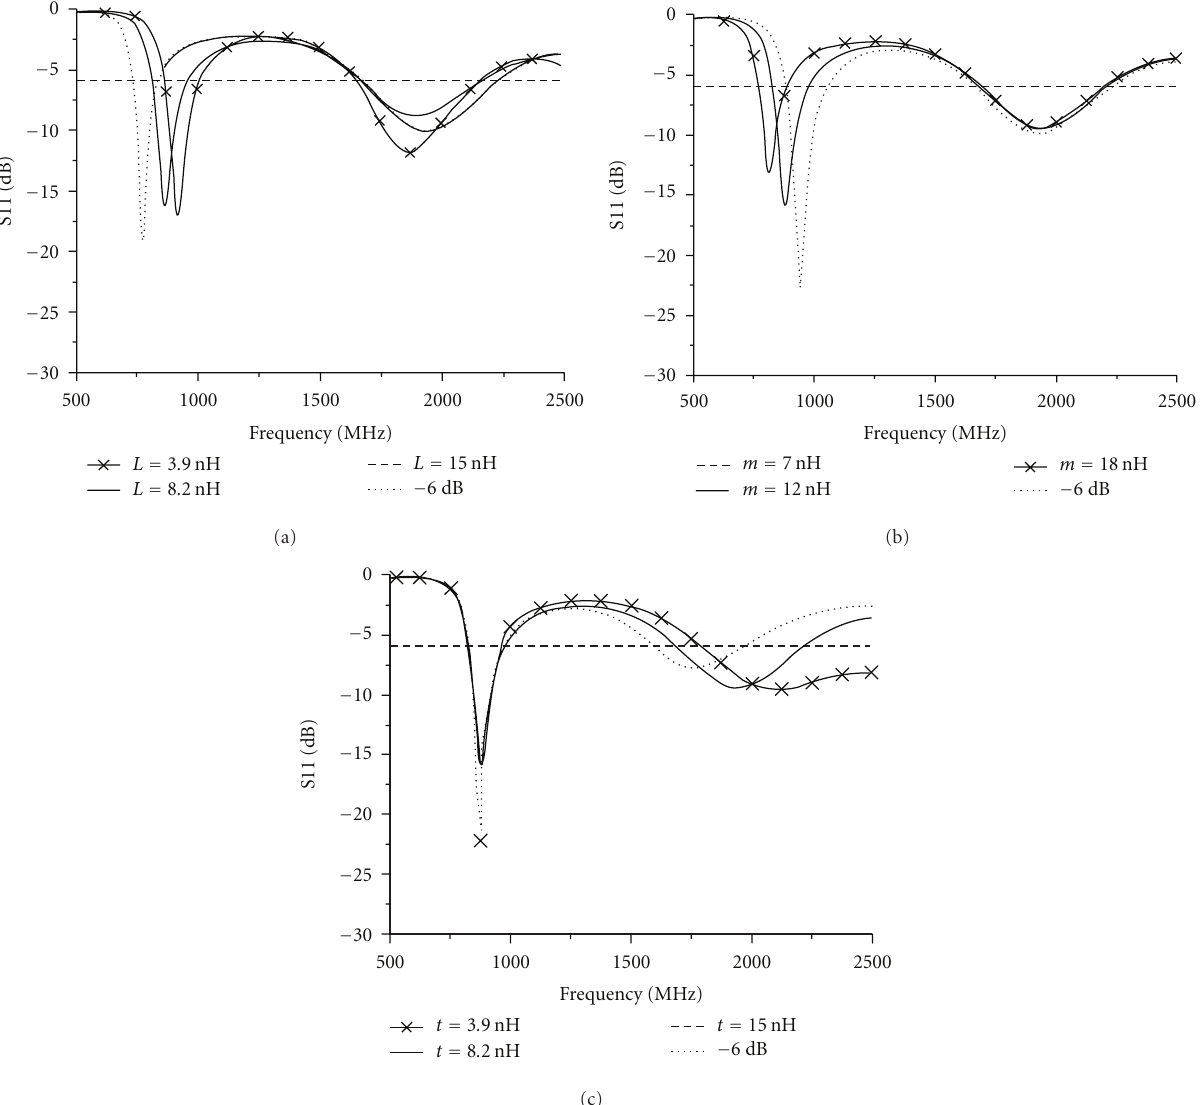
Figure 9: Simulated reflection coe ffi cient for the proposed antenna as a function of (a) the value of the inserted inductor, (b) the length of the coupling strip and (c) the length of the feeding strip. Other dimensions are the same as in Figure